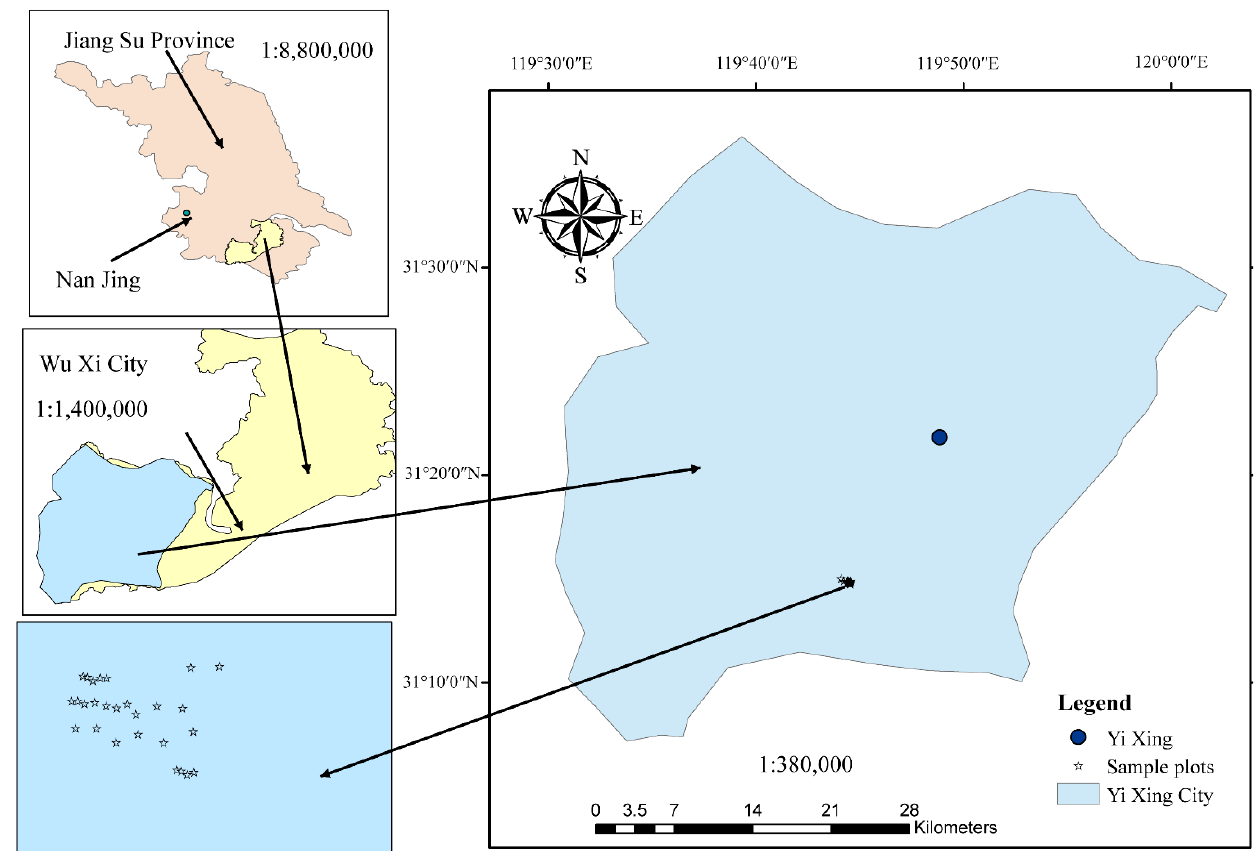
Figure 2. Study area showing the location of the sample plots.